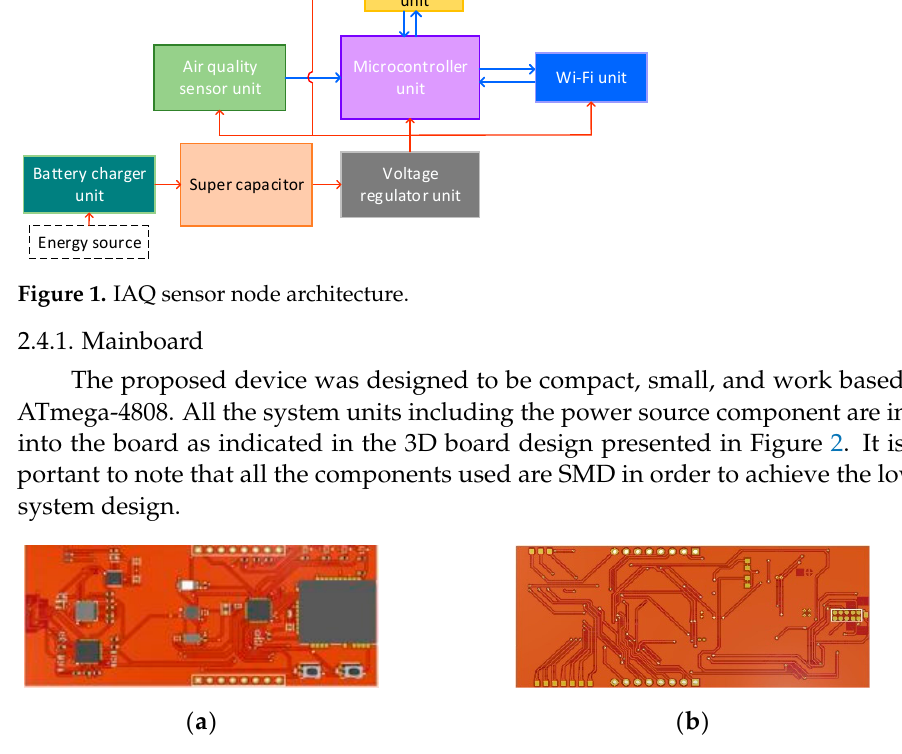
Figure 2. PCB design of IAQ sensor node: ( a ) top layer and ( b ) bottom layer.